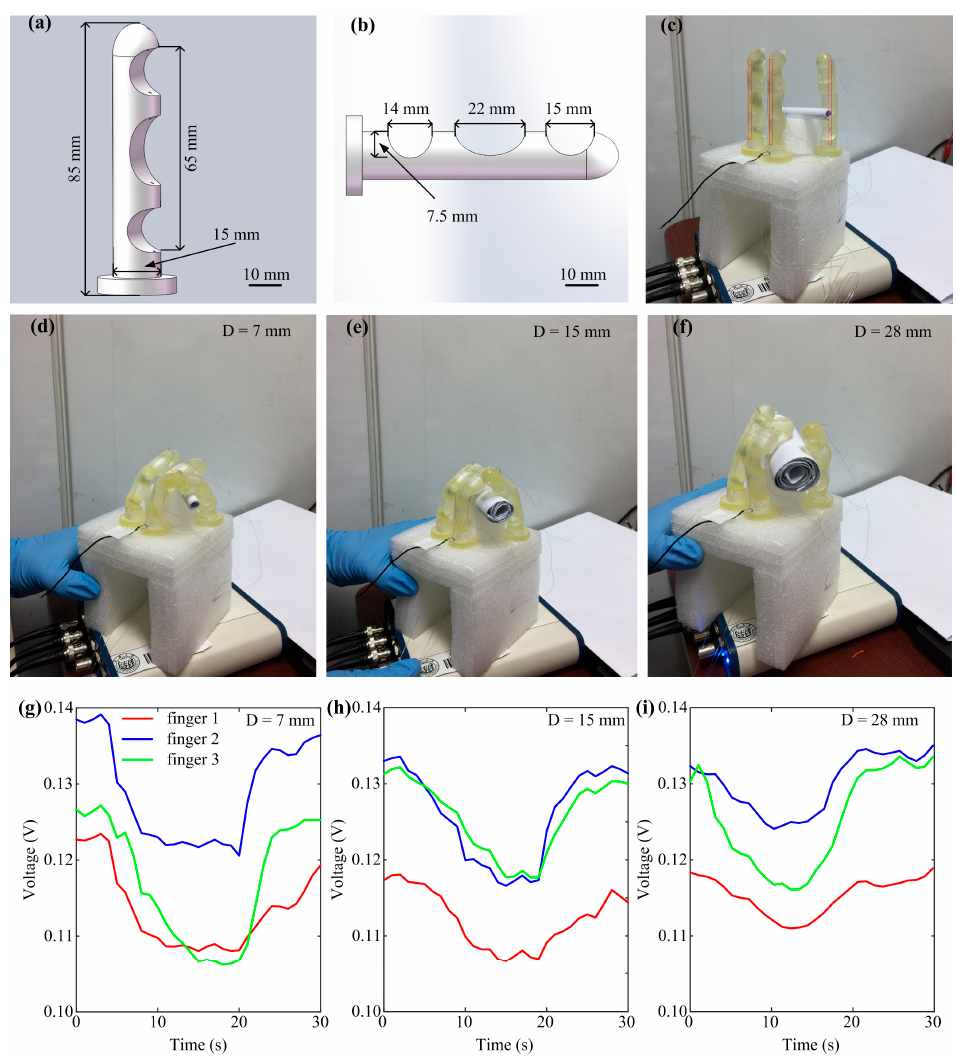
Figure 10. Grasp sensing of a three-finger soft gripper with gel strips. ( a ) Design of a soft finger for 3D printing. ( b ) Flexure hinges of a soft finger. ( c ) Three soft fingers of the gripper stood straight without pulley pulling and bent to grasp rods with diameters of 7 mm ( d ), 15 mm ( e ), and 28 mm ( f ). ( g – i ) Voltages on sampling resistors decreased when the gripper held rods with diameters of 7, 15, and 28 mm. The red lines in ( c ) indicate where the gel strips were attached. Table 1. Stretching analyses of gel strips for grasping.